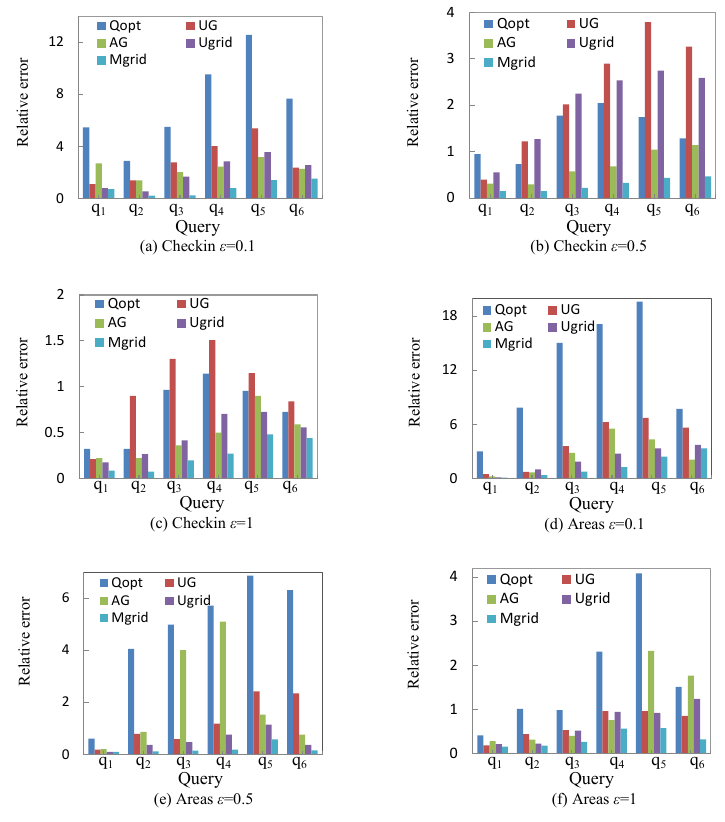
Figure 5. Relative error of